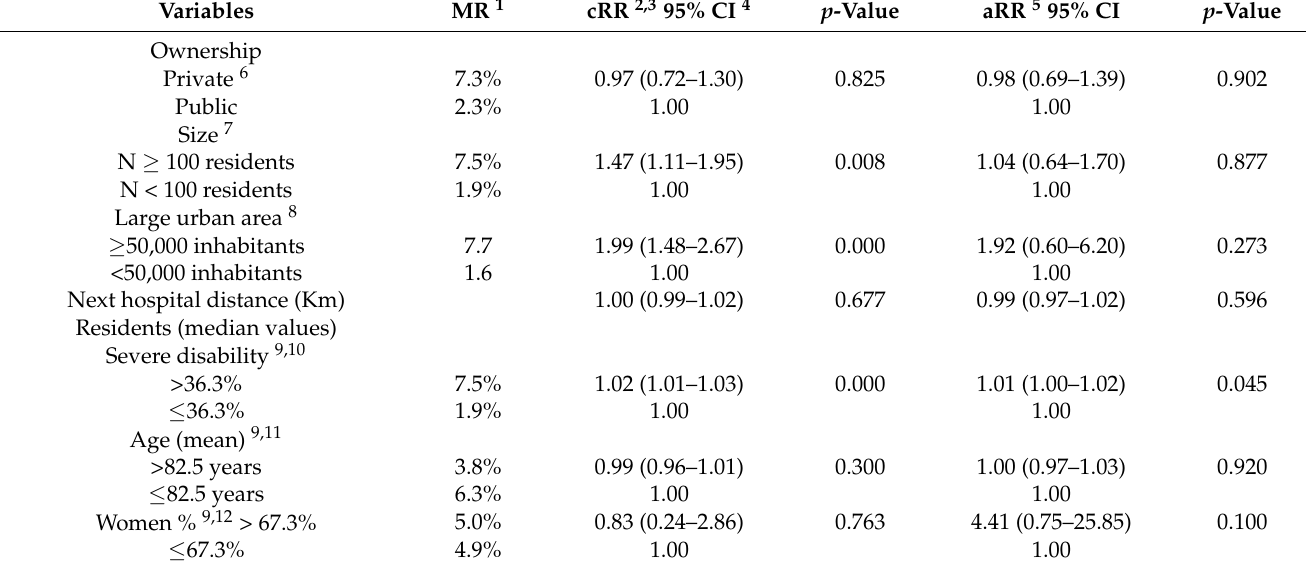
Table 5. Risk factors of the mortality rate (MR) of COVID-19 in residents of nursing homes (I). Health Departments 2 and 3 of Castellon. March 2020–January 2021.